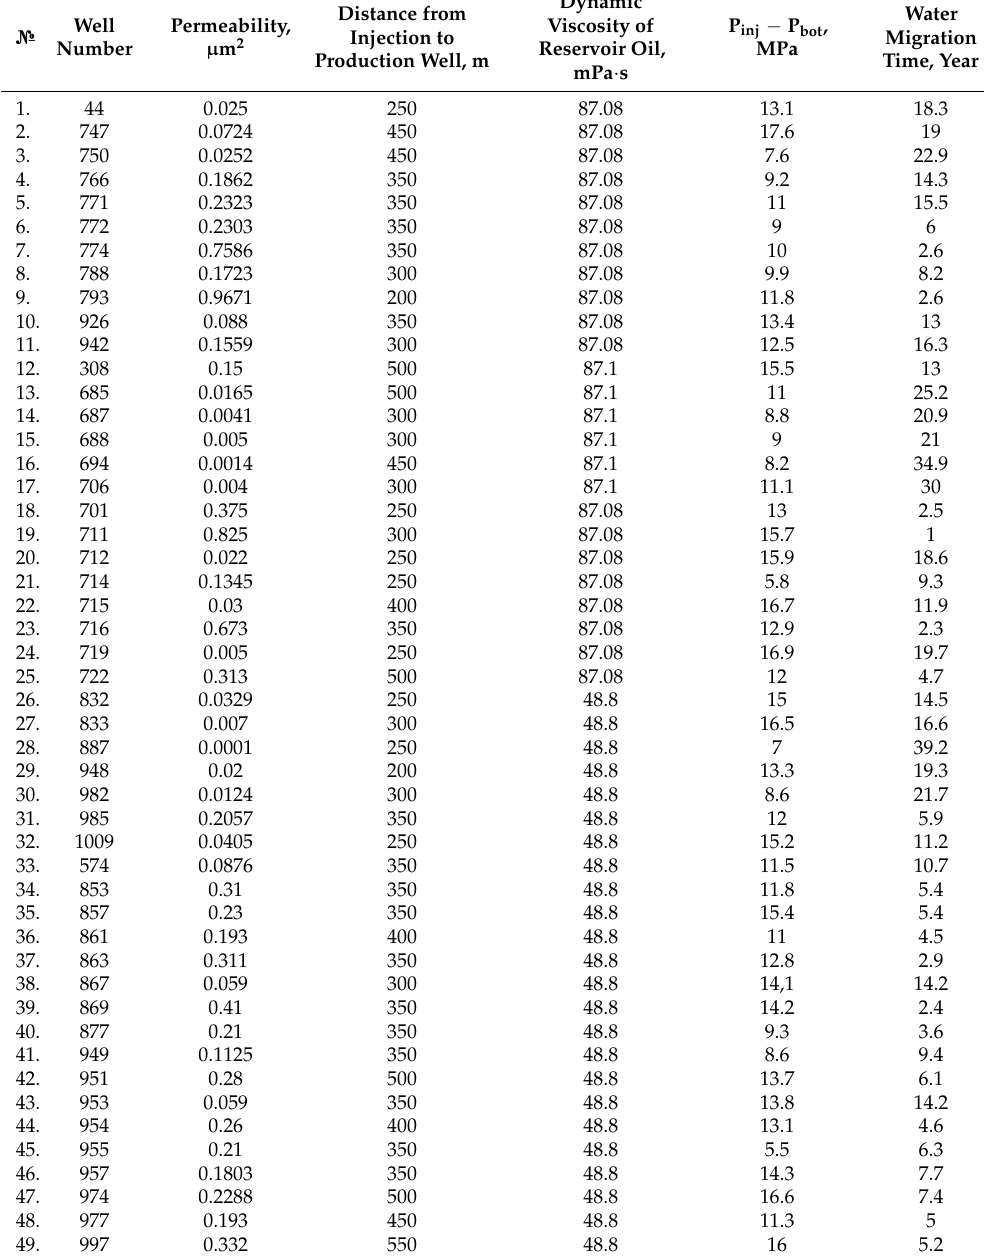
Table 6. Water migration time from the injection well to the production